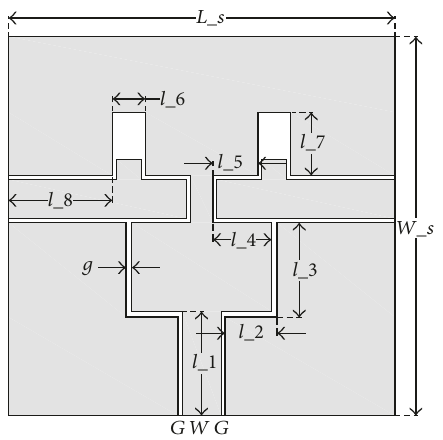
Figure 2: The geometry of the 3 dB CPW power splitter.